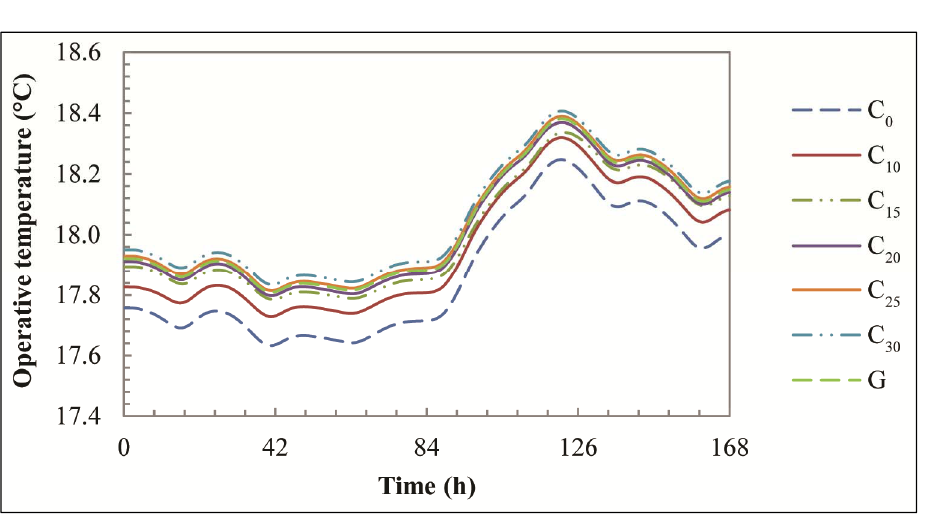
Figure 13. Operative temperature calculated by using the different concrete mixtures.